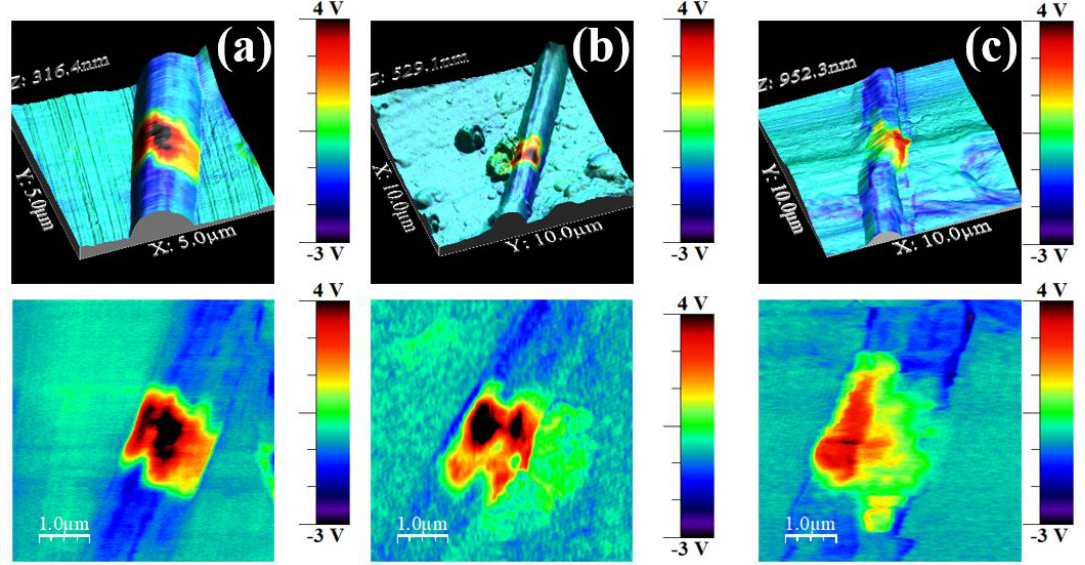
Figure 8. PFM images after poling (U = − 75 V, t = 50 s).